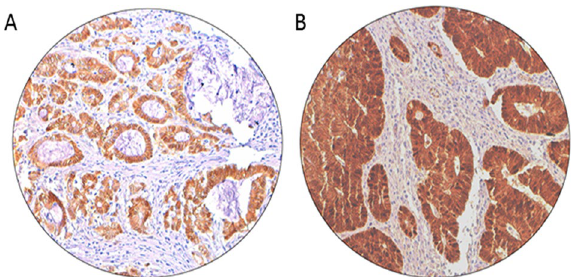
Figure 2. β-catenin immunohistochemical staining in colorectal carcinoma. Representative examples of tumors showing ( A ) absent nuclear expression and ( B ) high nuclear expression (right panel) of β-catenin.